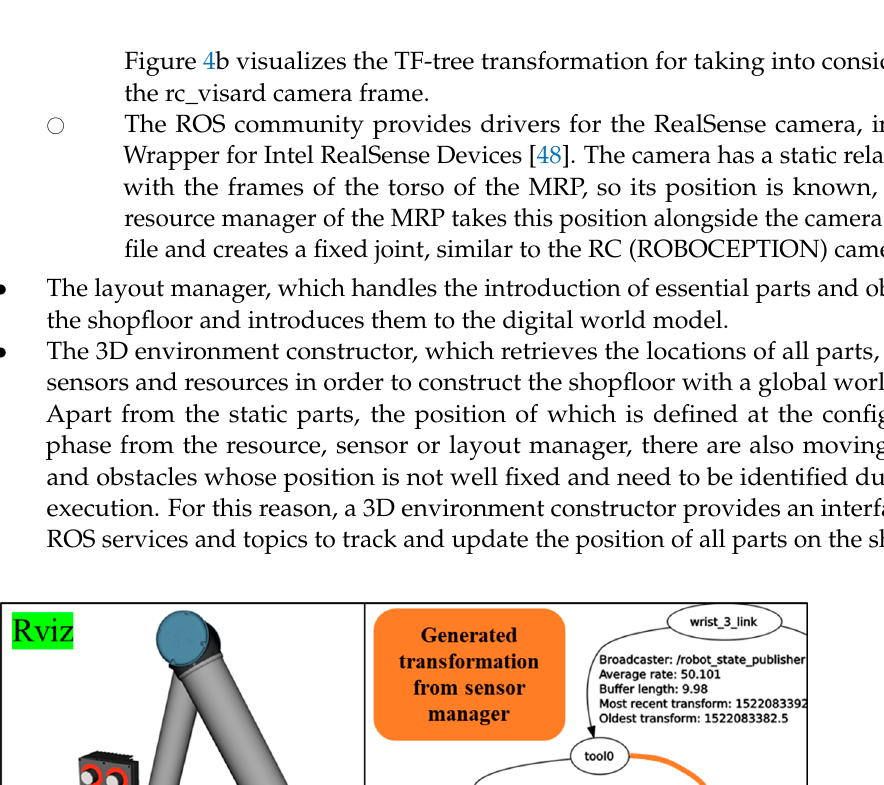
Figure 4b visualizes the TF-tree transformation for taking into consideration